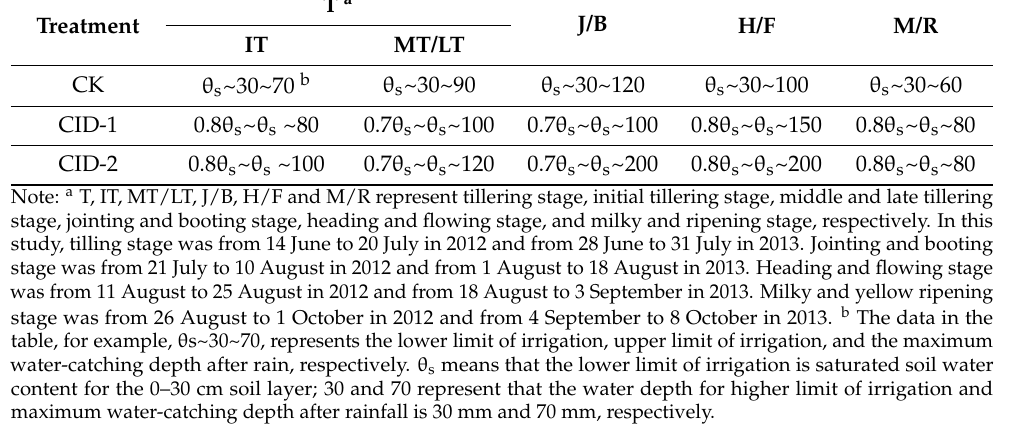
Table 1. Soil moisture limits for irrigation at different stages of rice under different irrigation regimes (2012–2013).